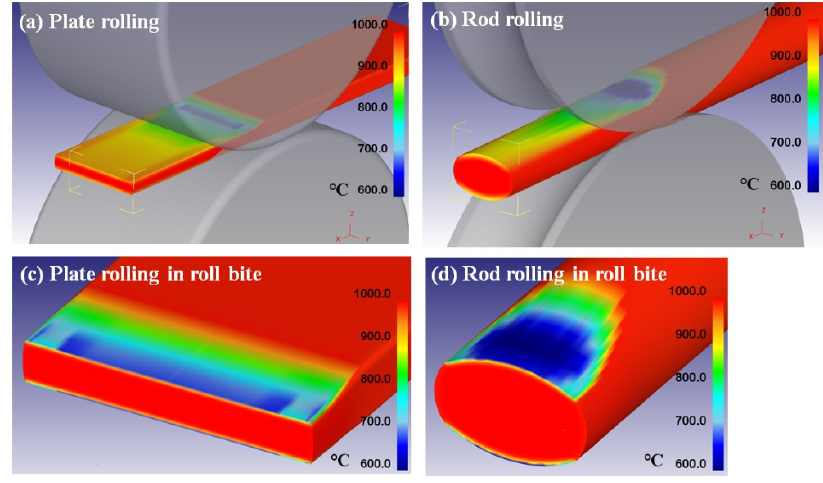
Figure 7. Comparison of contour maps of temperature during plate rolling and rod rolling.